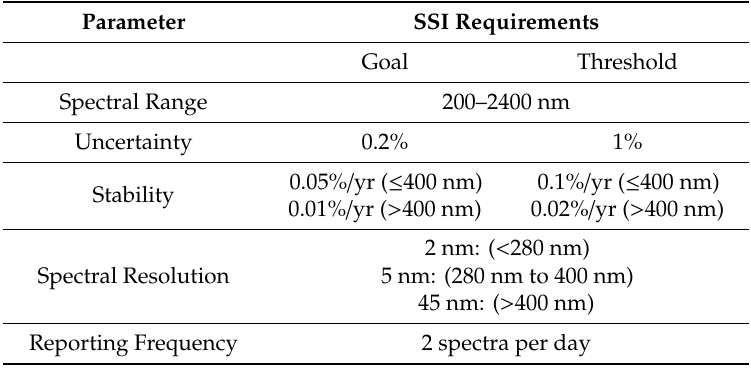
Table 1. Solar spectral irradiance (SSI) Level-1